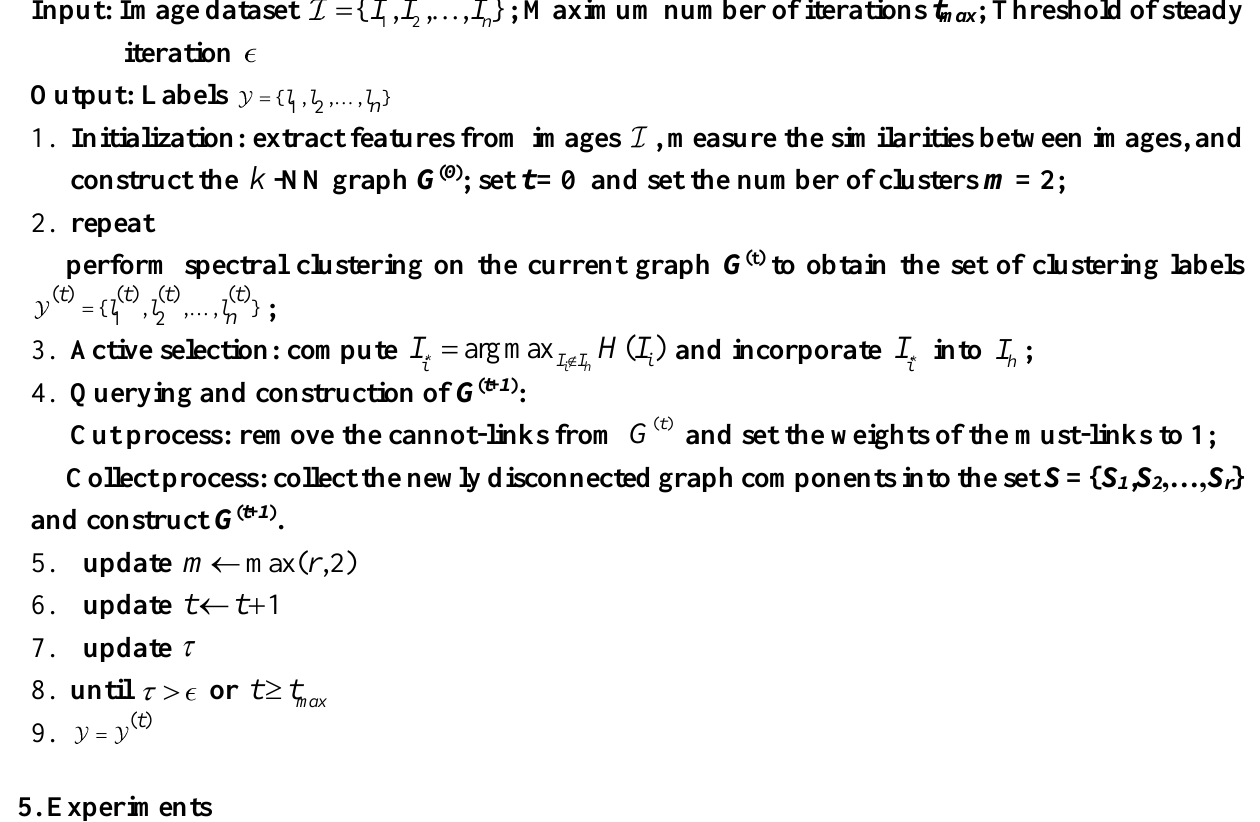
Algorithm 2. AASC: Adaptive Active Spectral Clustering of Remote Sensing